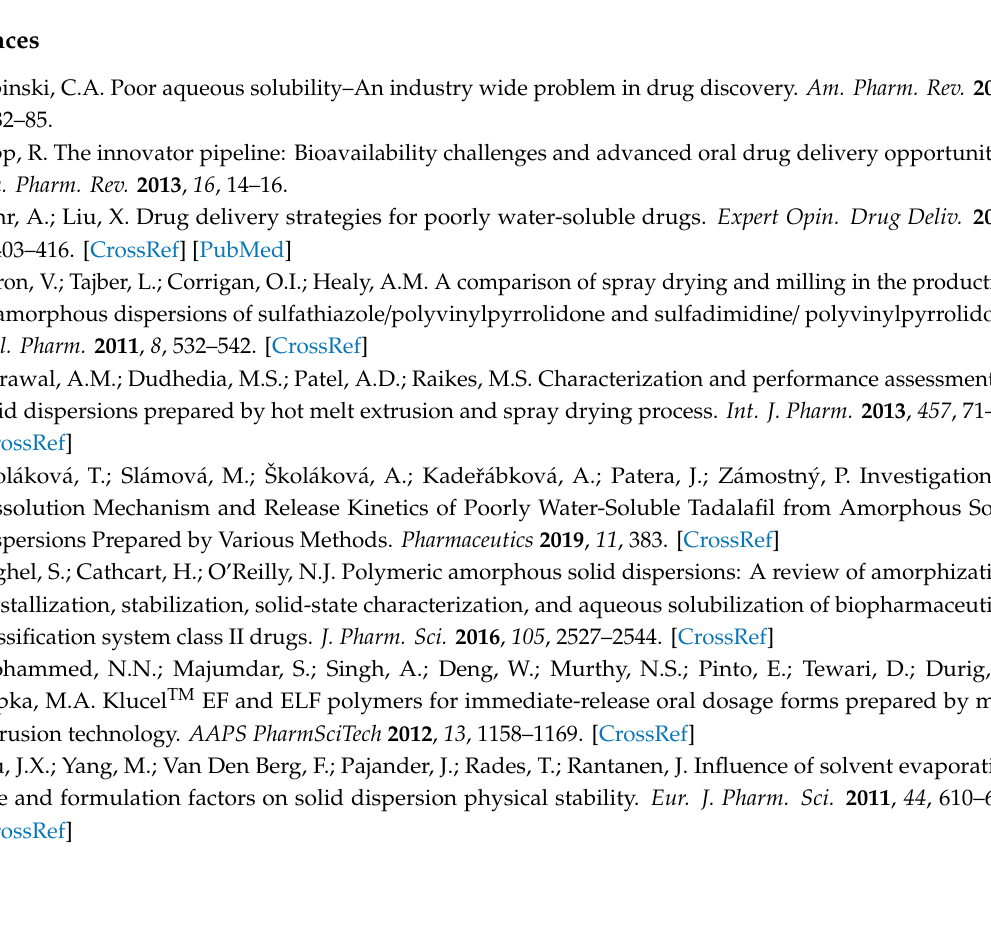
Di ff erential scanning calorimetry scans showing glass transitions / melt endotherm of PVAlcohol, Figure S3: mDSC calorimetry scans showing melt endotherm and glass transition of ketoprofen, Figure S4: PVP30 and ketoprofen ATR-FTIR spectra. Melt-quenched (MQ) PVP30KETO and physical mixture (PM) PVP30KETO, Figure S5: PVP90 and ketoprofen ATR-FTIR spectra. Melt-quenched (MQ) PVP90KETO and physical mixture (PM) PVP90KETO, Figure S6: PVP:VA 7:3 and ketoprofen ATR-FTIR spectra. Melt-quenched (MQ) VP:VA 7:3 KETO and physical mixture (PM) VP:VA 7:3 KETO, Figure S7: PVP:VA 3:7 and ketoprofen ATR-FTIR spectra. Melt-quenched (MQ) VP:VA 3:7 KETO and physical mixture (PM) VP:VA 3:7 KETO, Figure S8: PVAcetate and ketoprofen ATR-FTIR spectra. Melt-quenched (MQ) PVAcetate KETO and physical mixture (PM) PVAcetate KETO, Figure S9: PVAlcohol and ketoprofen ATR-FTIR spectra. Melt-quenched (MQ) PVAlcohol KETO and physical mixture (PM) PVAlcohol KETO, Figure S10: PVAP and ketoprofen ATR-FTIR spectra. Melt-quenched (MQ) PVAP KETO and physical mixture (PM) PVAP KETO, Figure S11: Dynamic solubility of vinyl pyrrolidone KETO systems at pH 1.2 at 2 hours versus parts vinyl pyrrolidone in the polymer, Figure S12: a) pXRD patterns of PVPKETO systems PVAlcoholKETO systems stored at 0% or 75% RH at 25 ◦ C for 12 weeks, Table S1: Gordon–Taylor predicted average ± standard